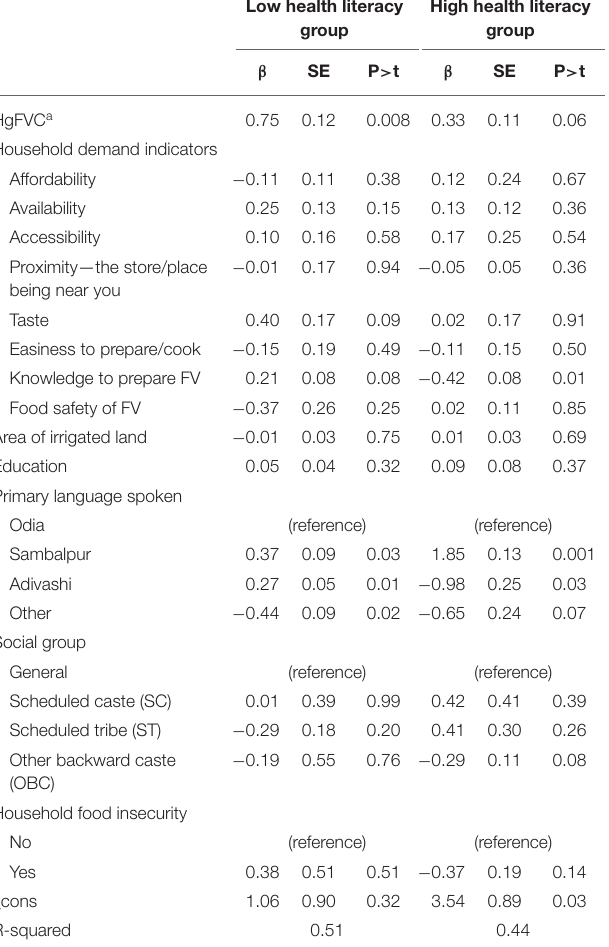
TABLE 4 | Subpopulation analyses for the servings of vegetables consumed per capita per day by high-/low-health literacy groups. Low health literacy High health literacy group group